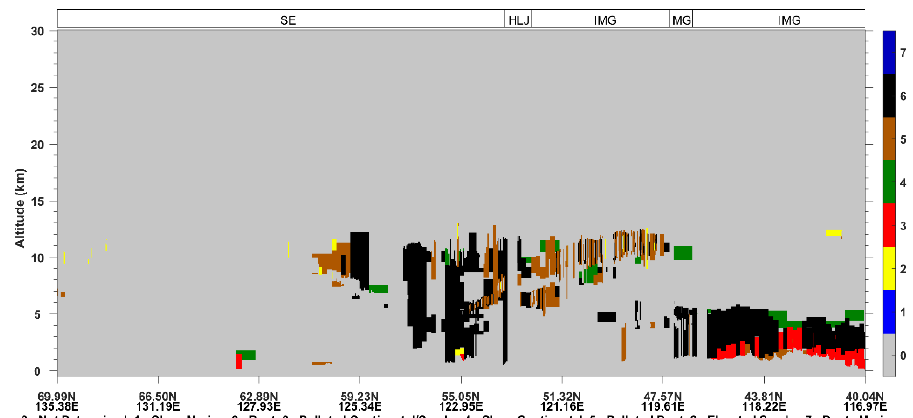
Figure 9. 26 June 2017: CALIOP-derived vertical profile of the vertical feature mask of aerosols over the ground track (dashed blue line) shown in Figure 1. CALIOP successively overpassed Siberia (SE), Heilongjiang Province (HLJ), Inner Mongolia Autonomous Region (IMG), Mongolia (MG), and IMG.